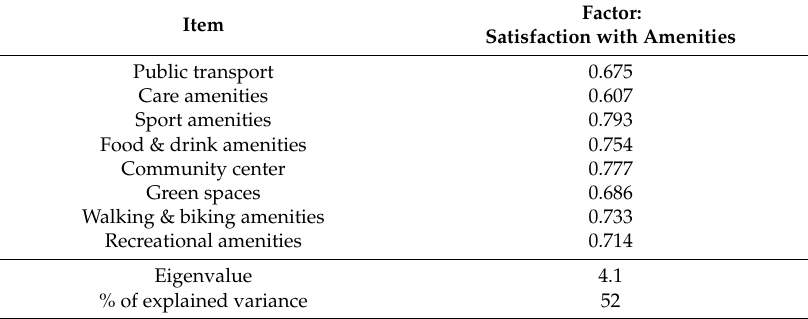
Table 6. Principal component analysis satisfaction with amenities in the